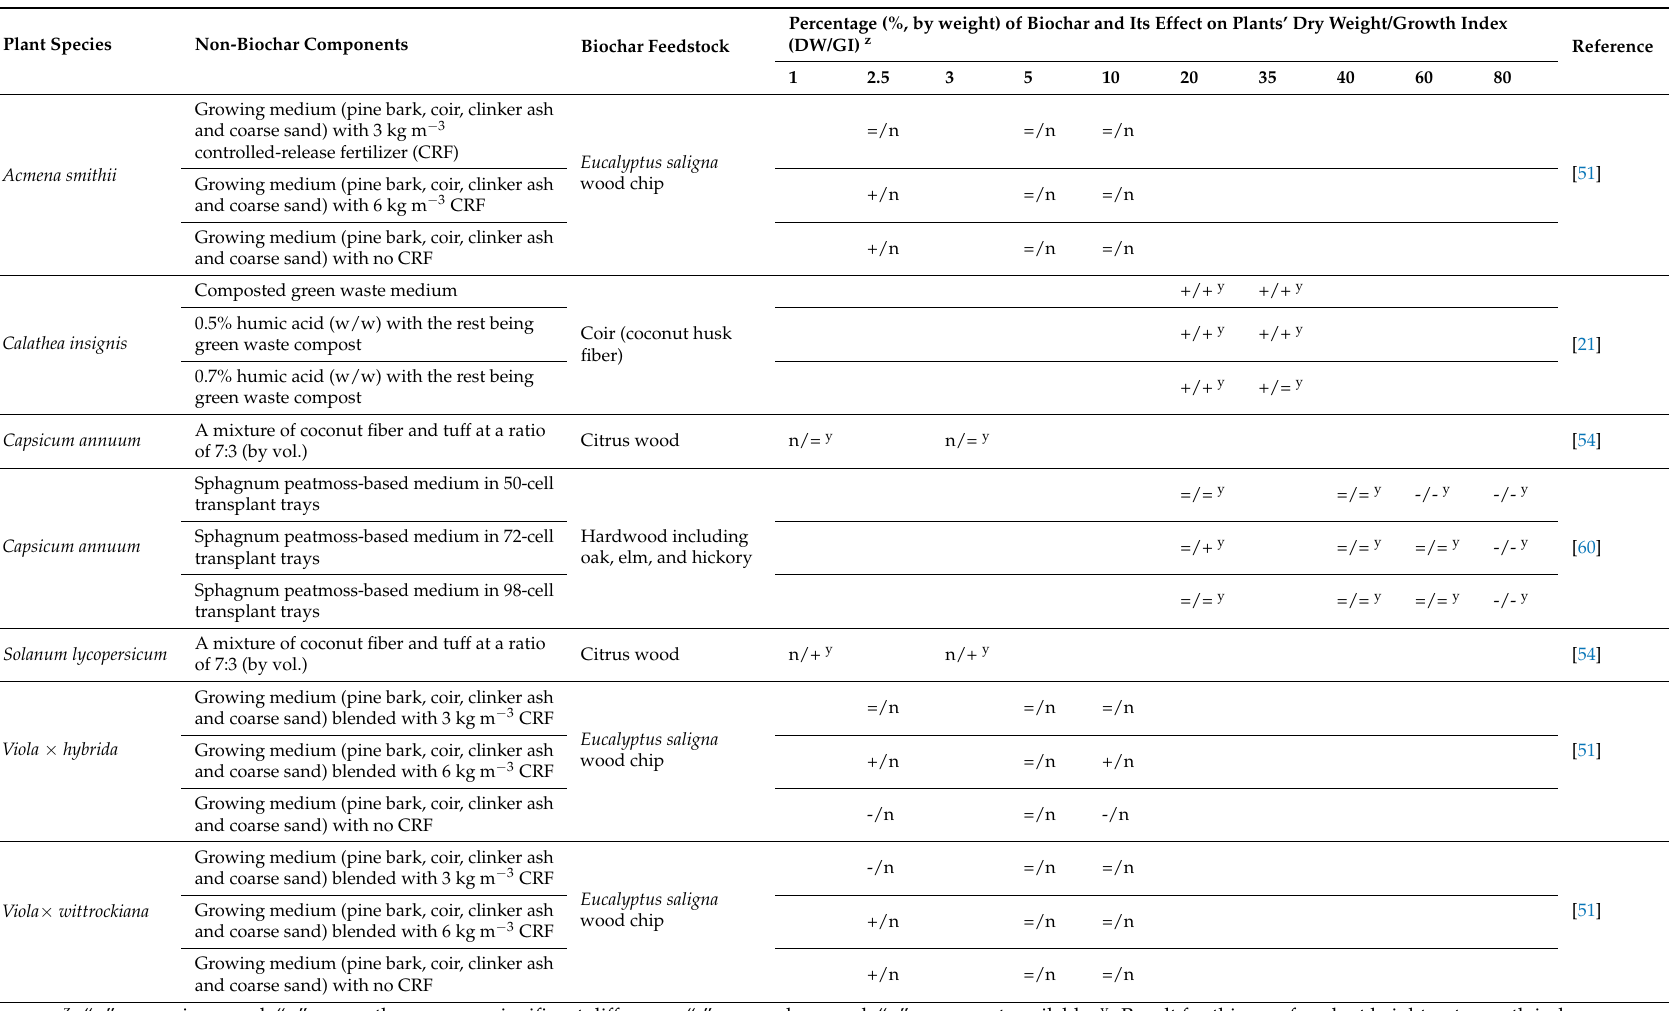
Table 4. Summary of the effects of biochar made from different feedstocks mixed with other substrate components on container-grown plants, with percentage of biochar in container substrates measured by